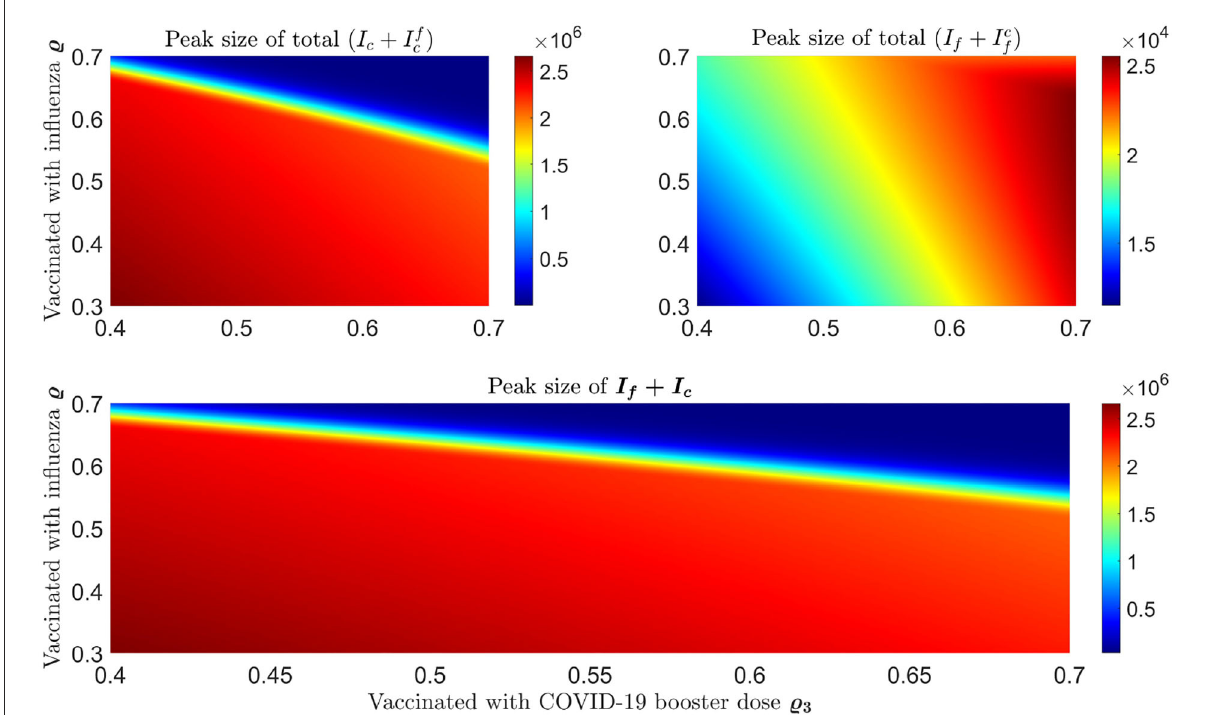
FIGURE9 Impact of increasing proportion of individuals vaccinated with the first booster dose of COVID-19 and influenza vaccines on the peak size of infections. The top left plot represents the total number of infections with COVID-19 ( I c ( t ) + I f c ( t )) and the top right plot shows the total number of infections with influenza ( I f ( t ) + I c f ( t )). Bottom panel shows the peak size of overall total COVID-19 and influenza cases ( I c ( t ) + I f c ( t ) + ( I f ( t ) + I c f ( t )).